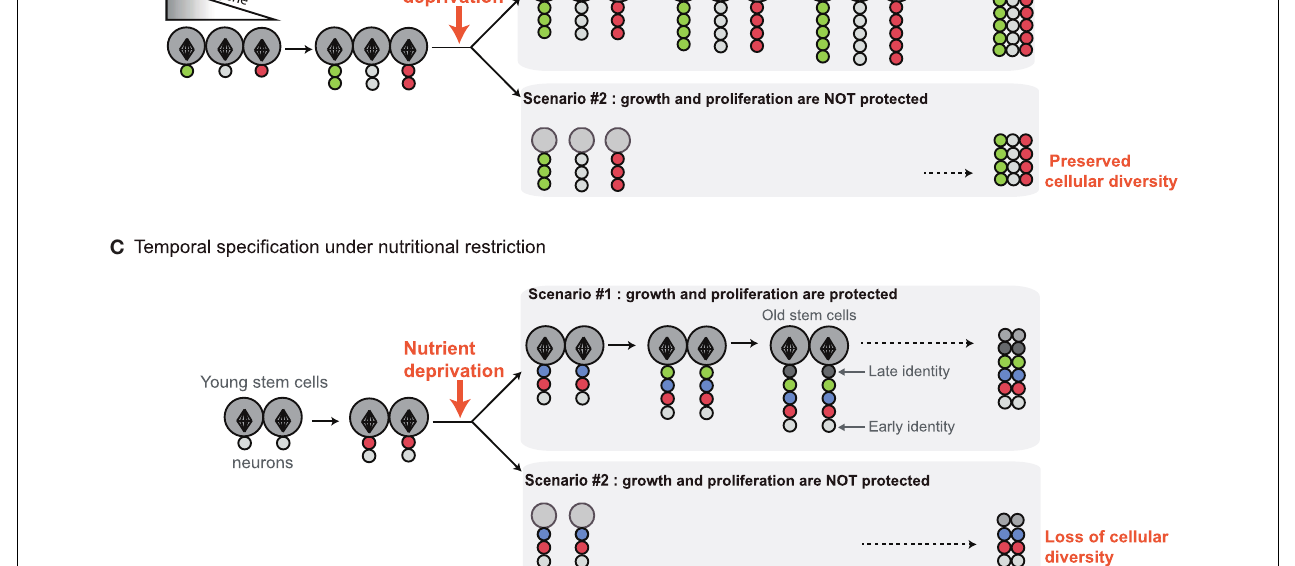
bodies, the transitions between neuronal identities are triggered by external signals. When signals are delayed, transitions to subsequent neuronal identities are also delayed. (B) In most organs, cell diversity mainly relies on the spatial specification of progenitors by gradients of morphogens. Initial spatial identity is transmitted to progeny generated throughout development. Precocious cell cycle arrest in the face of NR will not affect cellular diversity in the tissue. (C) In the nervous system, temporal patterning ensures that neural progenitors generate different types of neurons as they progress through successive rounds of asymmetric divisions. Precocious cell cycle arrest in the face of NR may perturb the production of progeny with late identities and, consequently, to reduce neuronal diversity in the lineage. This suggests that tissues subjected to temporal patterning are likely to be protected against